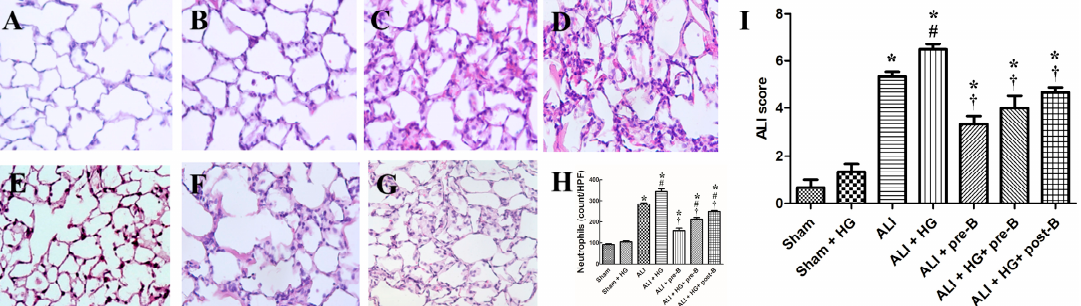
Figure 3. Effects of hyperglycemia and NKCC1 inhibitor treatment on the histopathological features in ALI and neutrophil sequestration. The sham ( A ) and sham + HG ( B ) groups exhibited normal histology. Sections from rats of the ALI ( C ) and ALI + HG ( D ) groups revealed severe lung injury with prominent alveolar exudation, alveolar septum thickening, and neutrophil sequestration. Pretreatment or post-ALI treatment with the NKCC1 inhibitor reduced lung injury, which was observable in ( E ) ALI + pre-B, ( F ) ALI + HG + pre-B, and ( G ) ALI + HG + post-B groups. The neutrophil counts ( H ) were high in rats with ALI and further increased in the ALI + HG group ( p < 0.05). The NKCC1 inhibitor reduced neutrophil counts in both ALI and ALI + HG groups ( p < 0.05). The ALI scores ( I ) were high in rats with ALI and further increased in the ALI + HG group ( p < 0.05). The NKCC1 inhibitor reduced ALI scores in both ALI and ALI + HG groups ( p < 0.05). *Significant difference, as compared to the sham group ( p < 0.05), # Significant difference, comparing the groups with HG to those without HG (I vs. II, III vs. IV, V vs. VI, and V vs. VII, p < 0.05), † Significant difference, comparing the ALI groups with B to those without B (III vs. V, IV vs. VI, and IV vs. VII, p < 0.05). Abbreviation: ALI = acute lung injury, HG = hyperglycemia, pre-B = pretreatment with bumetanide, post-B = post-treatment with bumetanide.